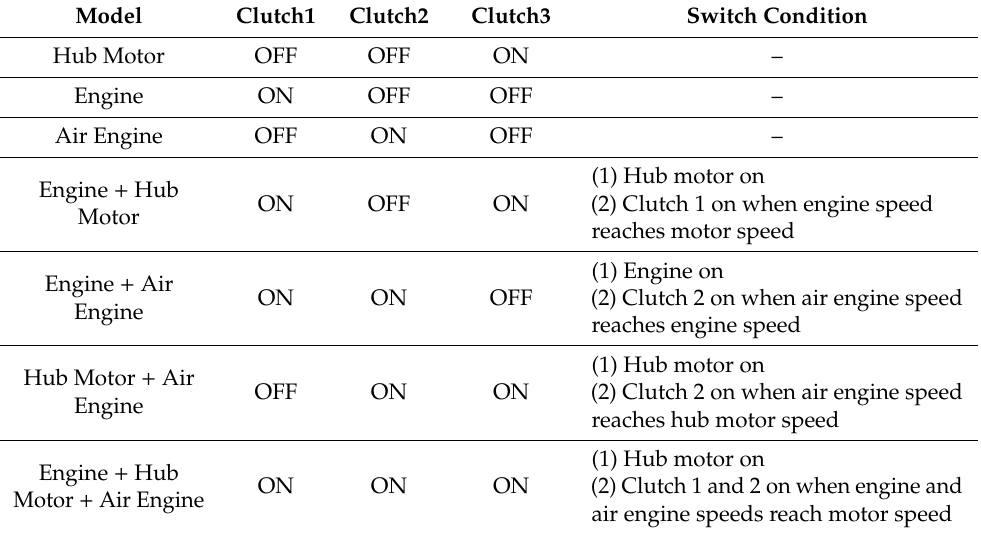
Table 1. Relationship of the seven modes and the clutch